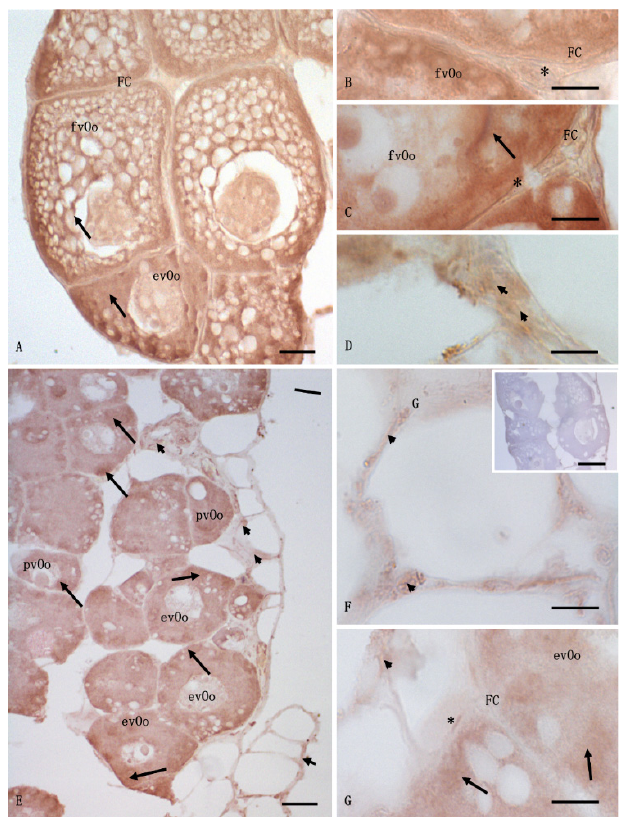
Figure 5. Light micrographs of Anguilla anguilla ovaries from control ( A – D ) and exposed specimens ( E – G ). Immunolabeling with anti-P450 aromatase antibody. ( A – D ) a wide and strong positive reaction was present in fully vitellogenic oocytes (fvOos) and early vitellogenic oocytes (evOos), as well as in the follicular (FCs), theca (asterisk), and connective cells (arrowheads). ( E – G ) previtellogenic (pvOos) and early vitellogenic oocytes (evOos) were immunolabeled, and the signal was in some areas of the cytoplasm as spots (arrow); positivity was also found in the theca (asterisk) and connective cells (arrowheads), while no signal was seen in the follicular cells (FCs). ( F insert ) negative control. No labeling was evident in the ovary. Bars: ( A ) = 20 µm; ( B – D , F , G ) = 5 µm, ( E ) = 50 µm, ( F inset ) = 100 µm.